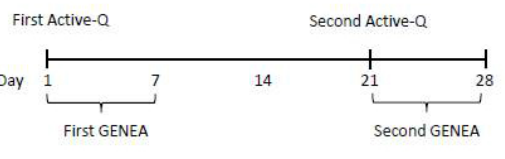
Figure 1. Timeline showing participants' responses to the first and second Active-Q questionnaire and when the first and second GENEA accelerometers were